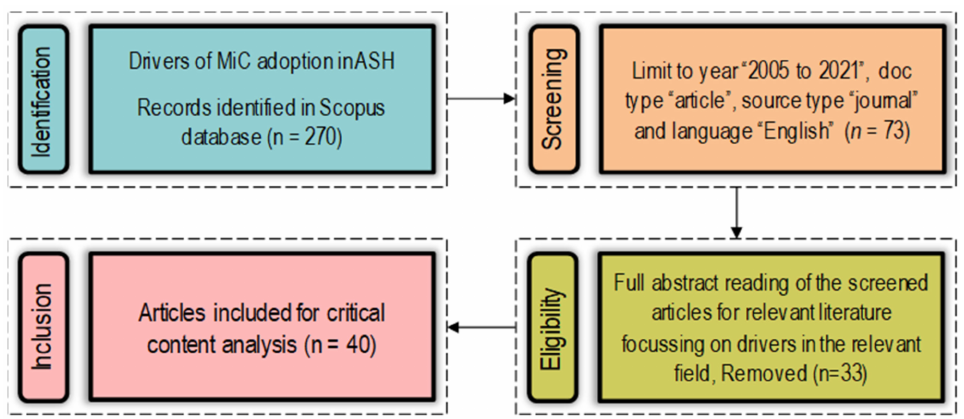
Figure 4. Steps of the PRISMA protocol for the article collection process. (Note: n represents number of